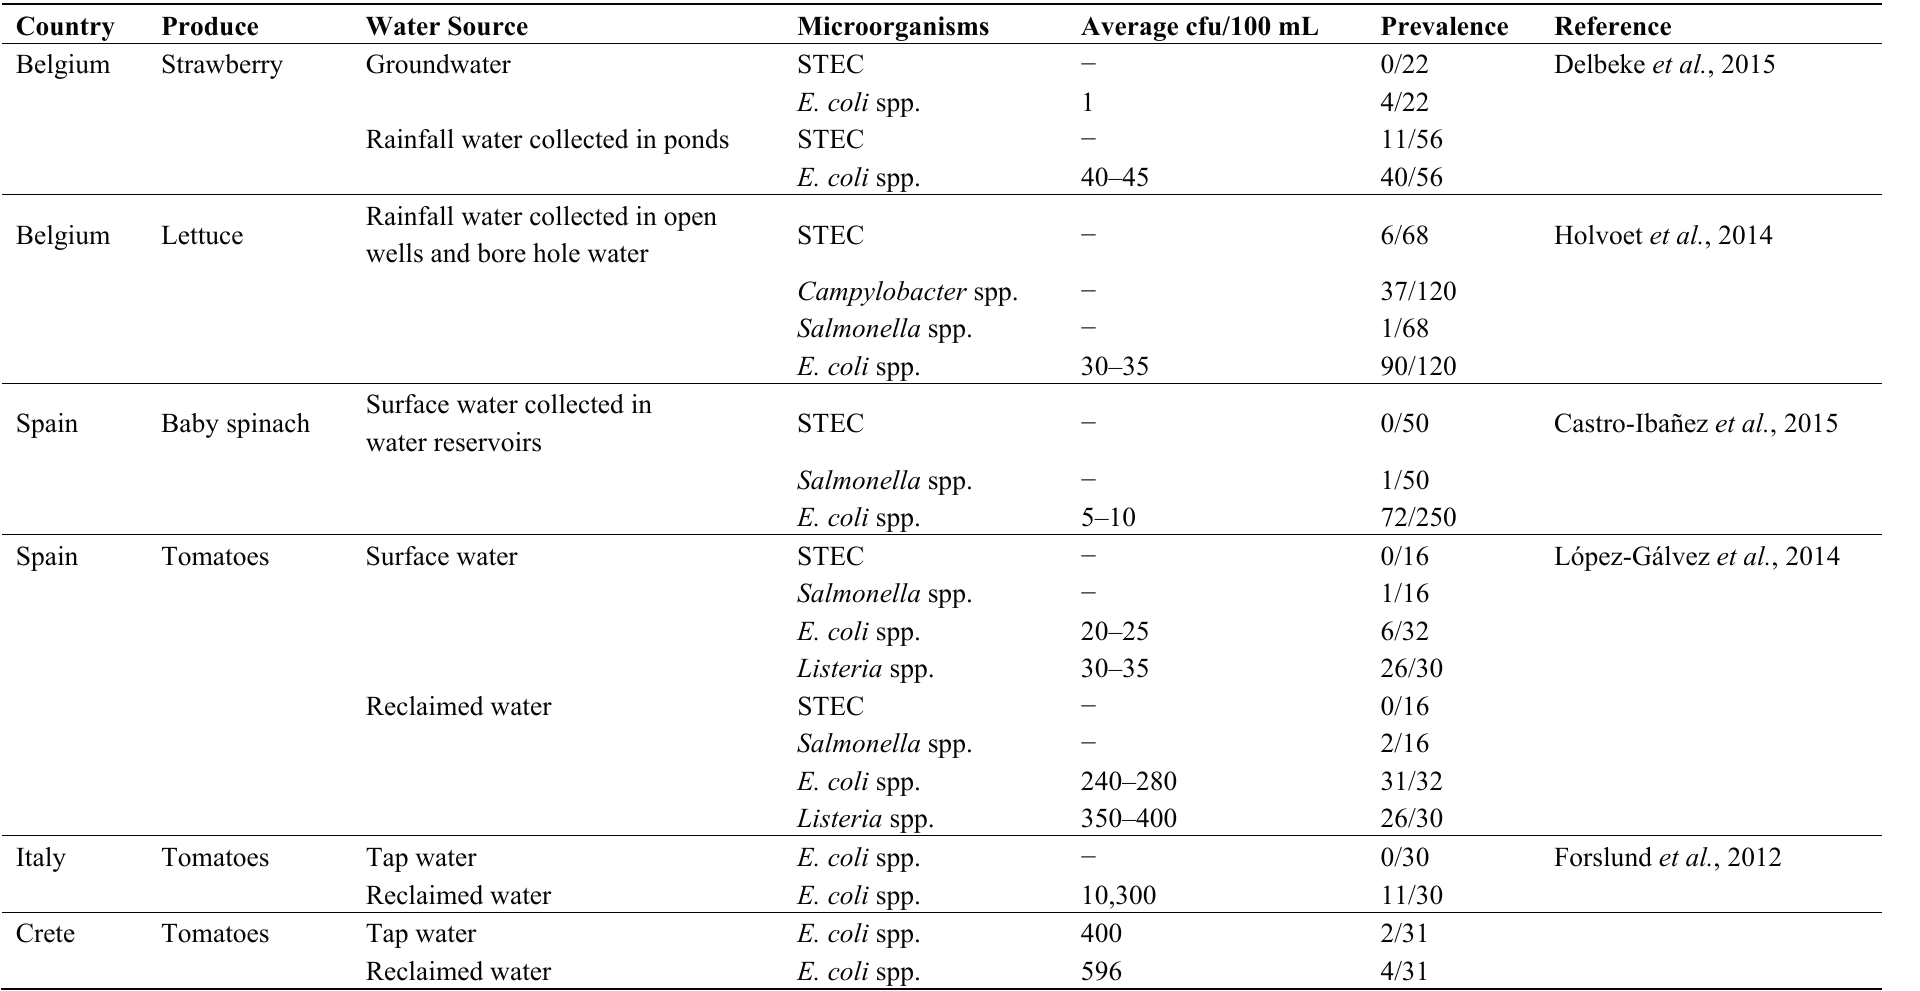
Table 1. Enumeration of microbial indicators and prevalence of foodborne pathogens in water used to irrigate fresh produce in Europe.